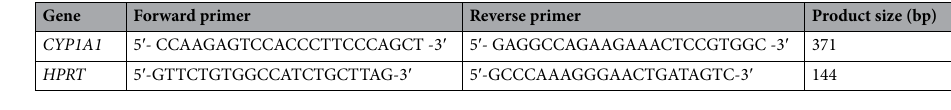
Table 1. Primer sequences